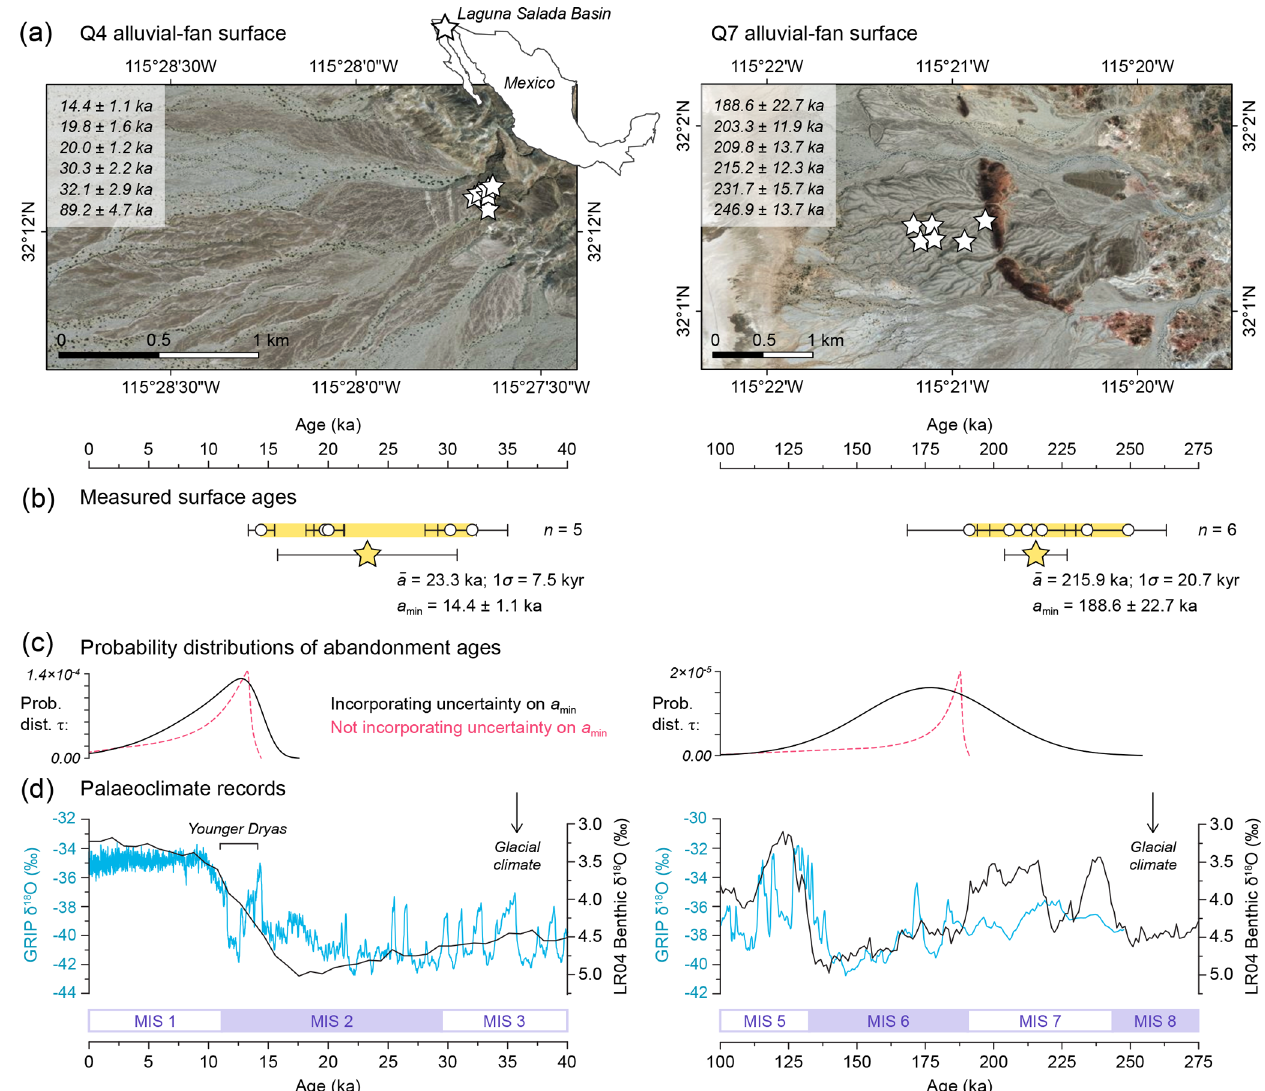
Figure 8. Two alluvial-fan surfaces in the Laguna Salada Basin, northern Baja California, Mexico. Left column shows the Q4 surface and right column shows the Q7 surface, after Spelz et al. (2008). (a) Locations of surface boulders sampled for 10 Be cosmogenic nuclide exposure dating. (b) Boulder exposure ages recalculated after Spelz et al. (2008) (white circles) and mean surface ages ± 1 σ (yellow stars). (c) Probability distributions of τ calculated using the MATLAB tool and incorporating uncertainty in a min (black). For illustrative purposes, probability distributions of τ are shown if uncertainty in a min is not incorporated (red dashed). (d) Selected palaeoclimate proxies: the GRIP ice core δ 18 O record from Greenland (blue; Johnsen et al., 1997) and the LR04 global benthic δ 18 O stack (black; Lisiecki and Raymo, 2005). Marine isotope stages (MIS) are indicated with